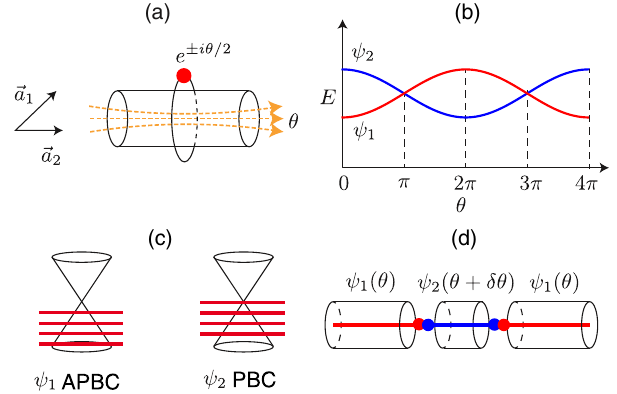
FIG. 2. Diagram for a spin liquid under the twist. (a) The spinon feels half-twist boundary or flux due to the fractionalization. (b) The response of the energy under the twist. (c) Two topological sectors of a DSL, with one gapped sector and one gapless sector. (d) The collapse of the twist simulation will have a quasiparticle emerging as the domain